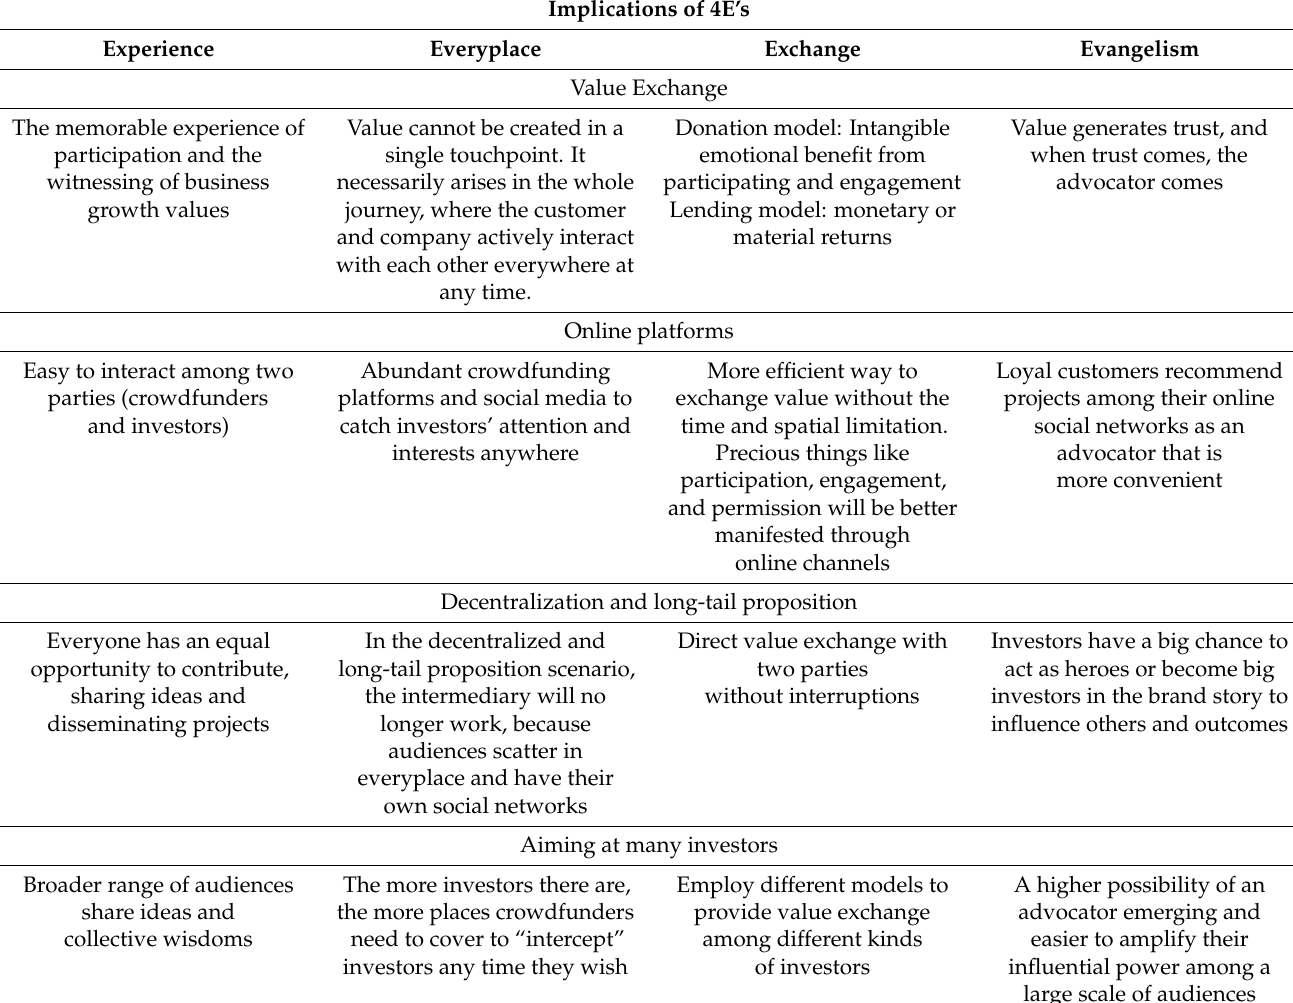
Table 1. The relationship between the 4Es and